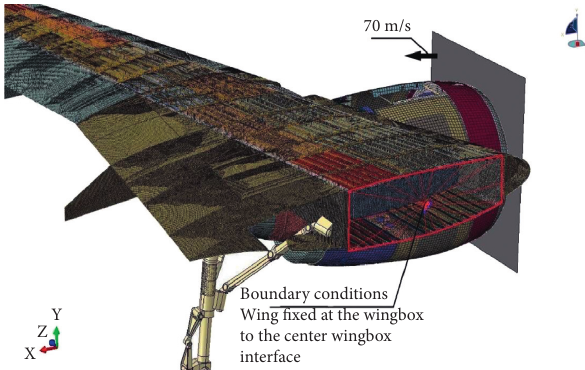
Figure 20: One side wing and nacelle model of wheel-up crashing with pitch angle (approaching impact).